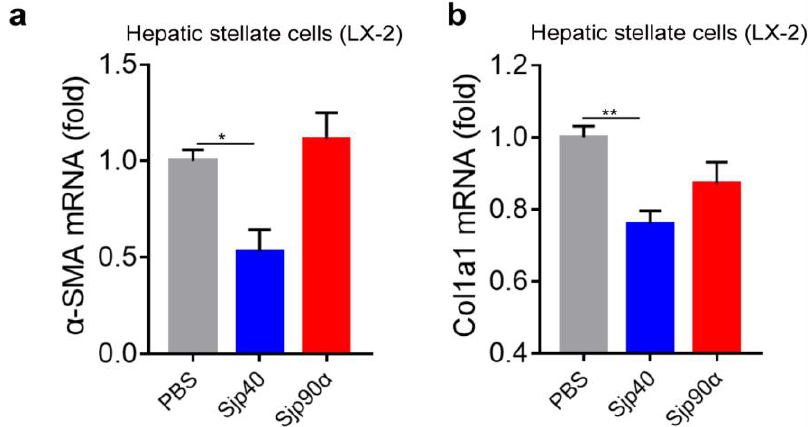
Figure 7. Different effects of rSjp40 and rSjp90α on α-SMA and COL1A1 expression in LX-2 cells. Transcript expression levels of α-SMA ( a ) and COL1A1 ( b ) in LX-2 cells co-cultured with PBS, rSjp40 and rSjp90α, respectively. β-actin was used as the internal standard for normalization. Data are expressed as the mean ± SEM ( n = 8 each group), ** p < 0.01, * p < 0.05, compared with PBS control.